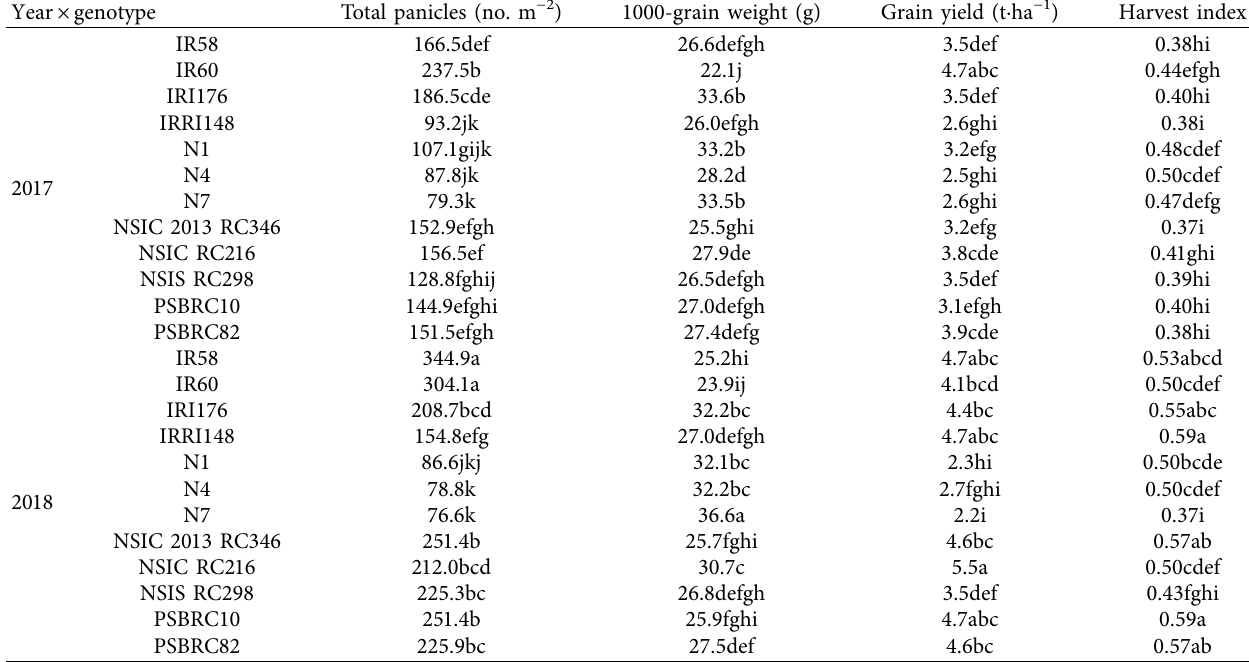
Table 4: Interactive effect of years and rice genotype on yield components and yield.